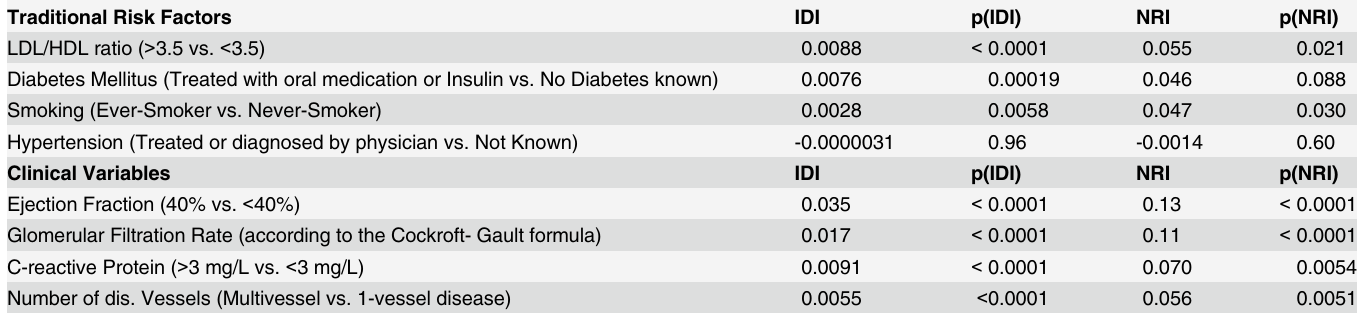
Table 6. Net reclassification table (NRI) and integrated discrimination improvement (IDI) in the Athero Gene study (N = 3229) after 5 years of follow- up. Traditional Risk Factors IDI p(IDI) NRI p(NRI) LDL/HDL ratio ( > 3.5 vs. <